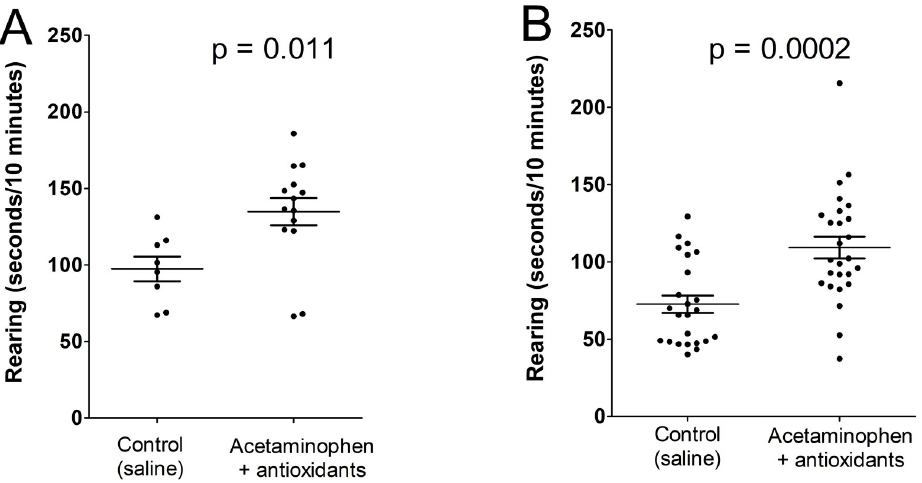
Fig 4. Effect of exposure to acetaminophen plus antioxidants on days P4 through P10 on rearing behavior at age P37 through P49. Results are shown in Panel A for animals receiving no oxidative stress factors (see Methods), and in Panel B for animals receiving oxidative stress factors. Results of post-hoc t tests are shown. Analysis of the combined data by 2-way ANOVA showed significant effects of acetaminophen + antioxidants (p < 0.0001) and of oxidative stress factors (p = 0.0036), but not for the interaction between the two (p =